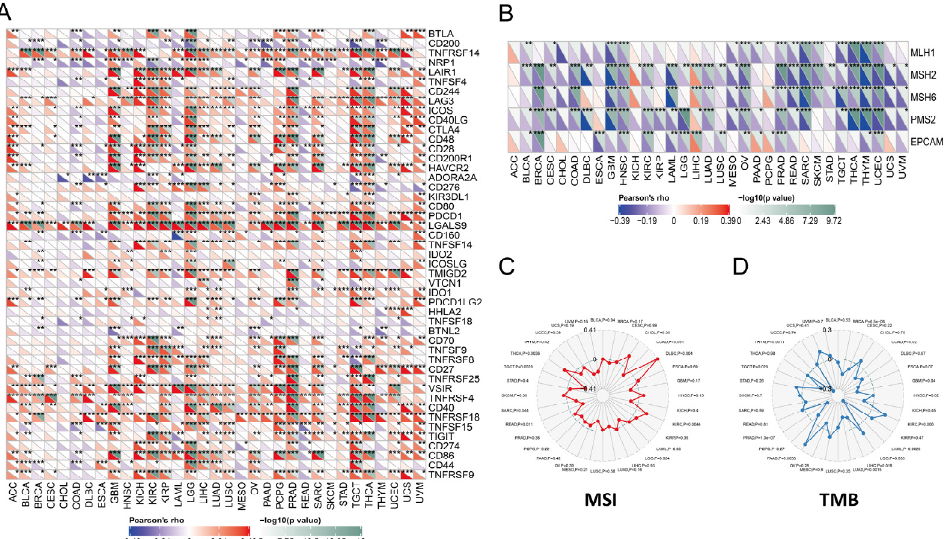
Figure 3. Pan-cancer associations between PYCARD expression and ICP genes, MMR genes, MSI, and TMB in human cancers. ( A ) PYCARD expression demonstrates significantly close associations with ICP genes in human cancers. ( B ) PYCARD expression demonstrates significantly close associations with MMR genes in human cancers. ( C ) PYCARD expression has positive relationships with MSI in THCA, DLBC, and KIRC, and negative relationships in TGCT, SARC, READ, and LGG. ( D ) PYCARD expression has negative relationships with TMB in THYM, TGCT, PRAD, LUAD, LIHC, LAML, COAD, and BRCA, and positive relationships with TMB in KIRC, PAAD, LGG, and GBM. (ICP, immune checkpoint genes; MMR, mismatch repair; MSI, microsatellite instability; TMB, tumor mutation burden) (* p < 0.05, ** p < 0.01, *** p < 0.001).